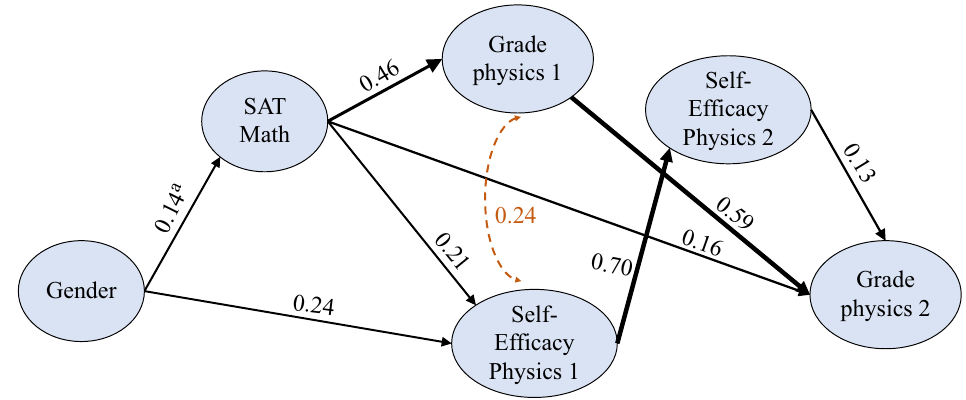
FIG. 4. Result of the path analysis part of the SEM without high school GPA between gender and physics 2 grade through students ’ self-efficacy for model 3. The line thickness indicates the relative magnitude of β values. The dashed lines indicate covariances between constructs. The p values are indicated by no superscript for p < 0 . 001 and superscript “ a ” for p ¼ 0 . 002 . Gender does not directly predict the physics 2